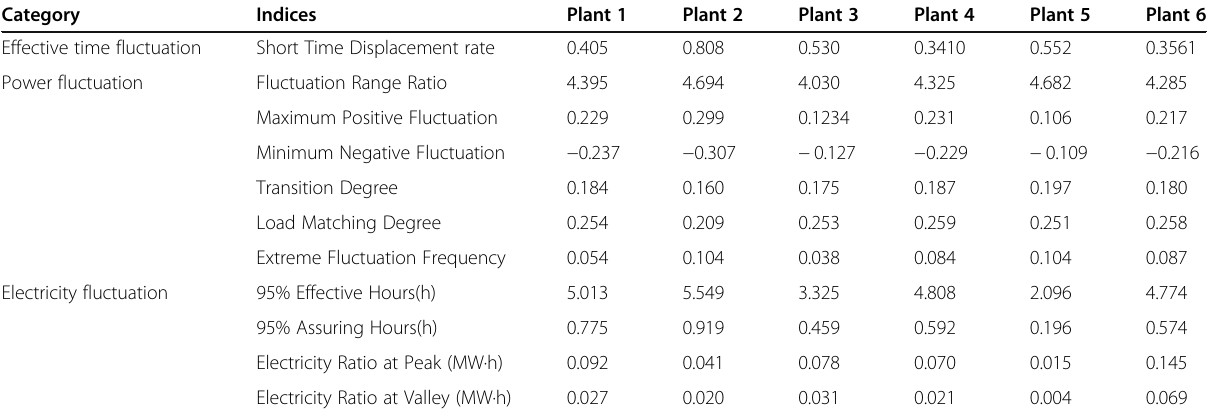
Table 3 Individual Indices result of six PV plants Category